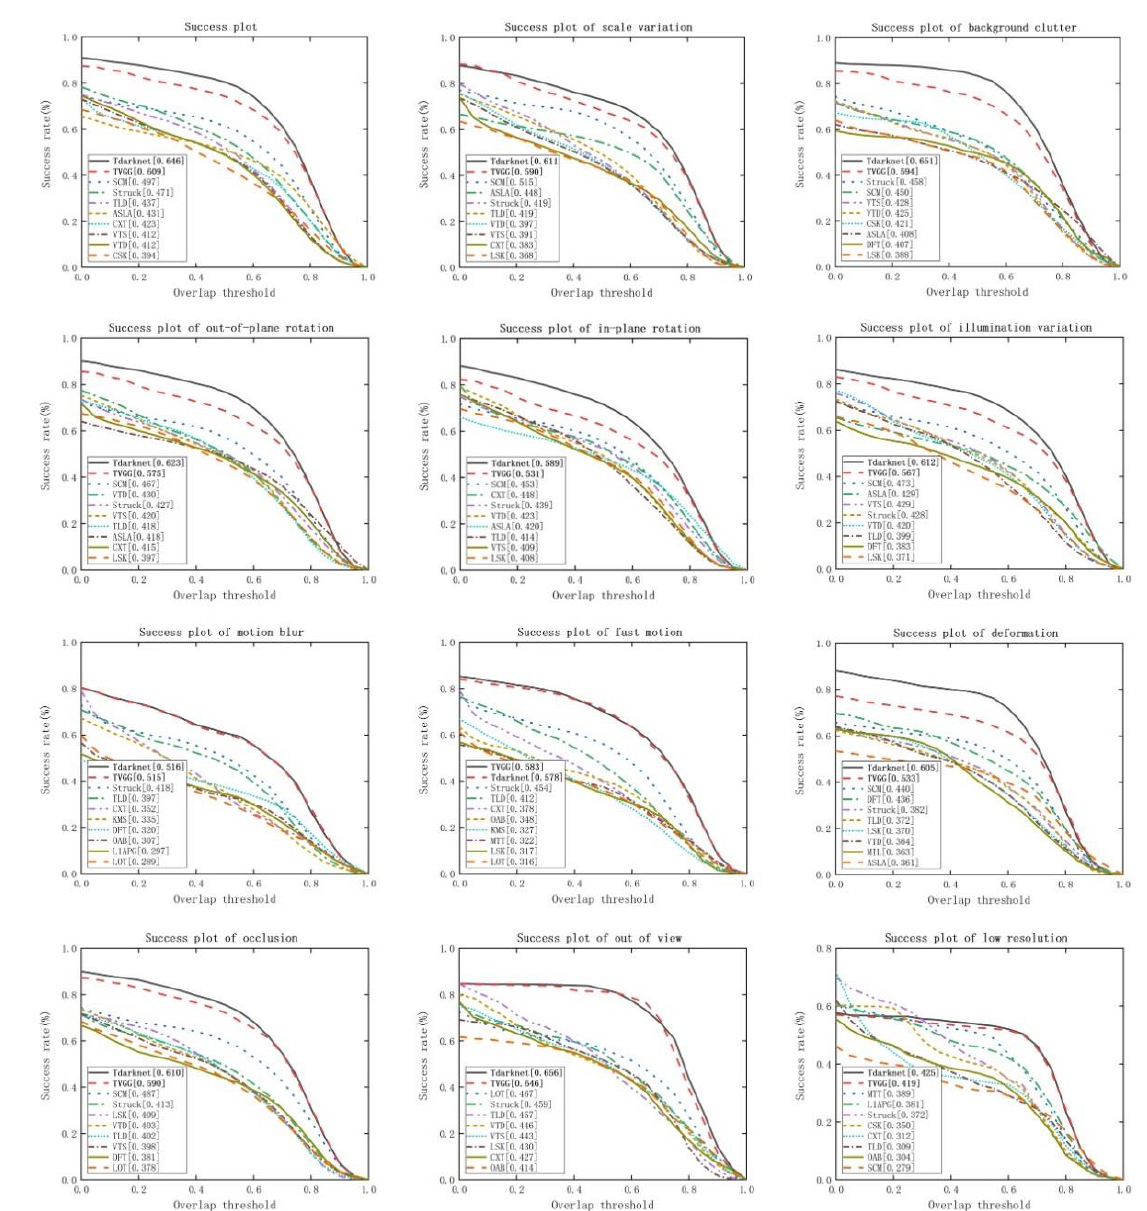
Figure 5. Tracking evaluation on OTB50 benchmark. OTB50 has different type of video, include illumination variation, scale variation, occlusion, deformation, motion blur, fast motion, in-plane rotation, out-of-plane rotation, out-of-view, background clutters and low resolution.